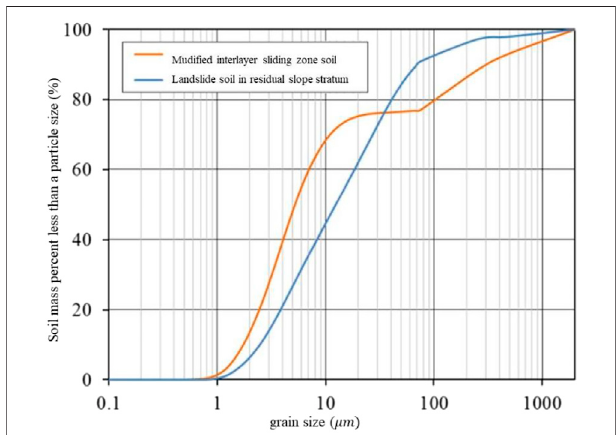
FIGURE 5 | Test results of particle size analysis.